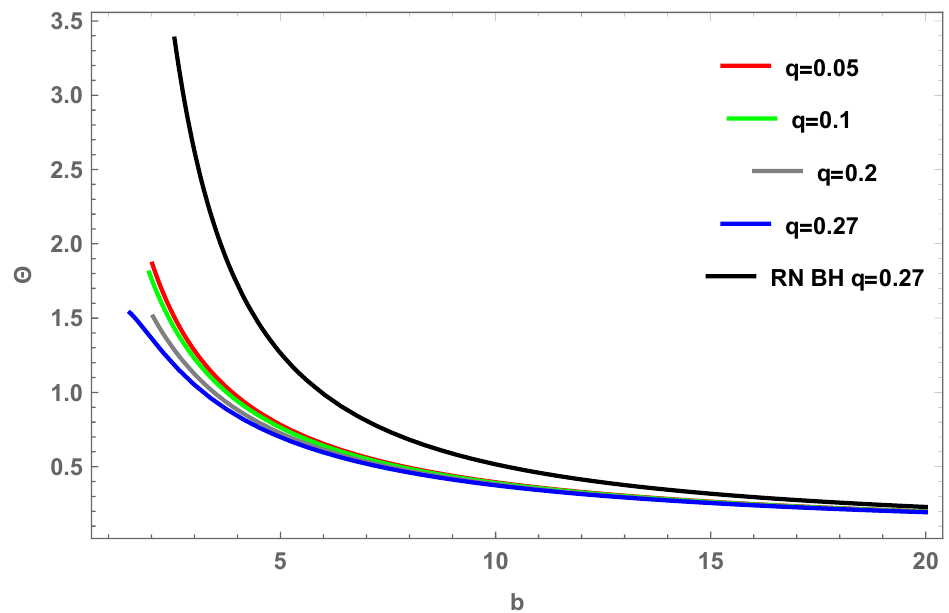
Figure 1. Relation between Θ and b of TCBH for positive values of q for M p = 1, M 5 = 0.5, M = 1.